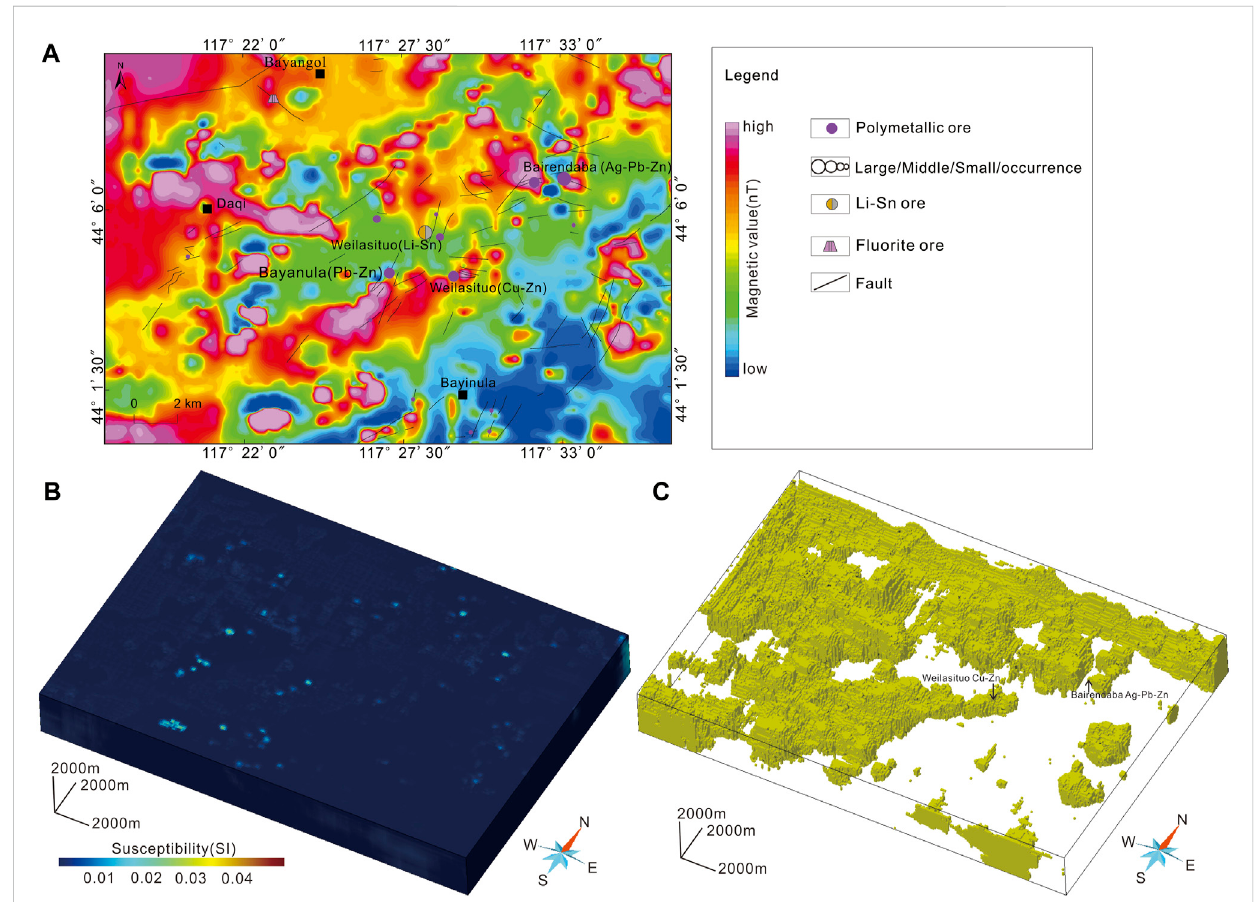
FIGURE 8 Magnetic susceptibility model of (A) 1:50000 magnetic anomaly distribution map; (B) the 3D susceptibility model (C) the high susceptibility geological